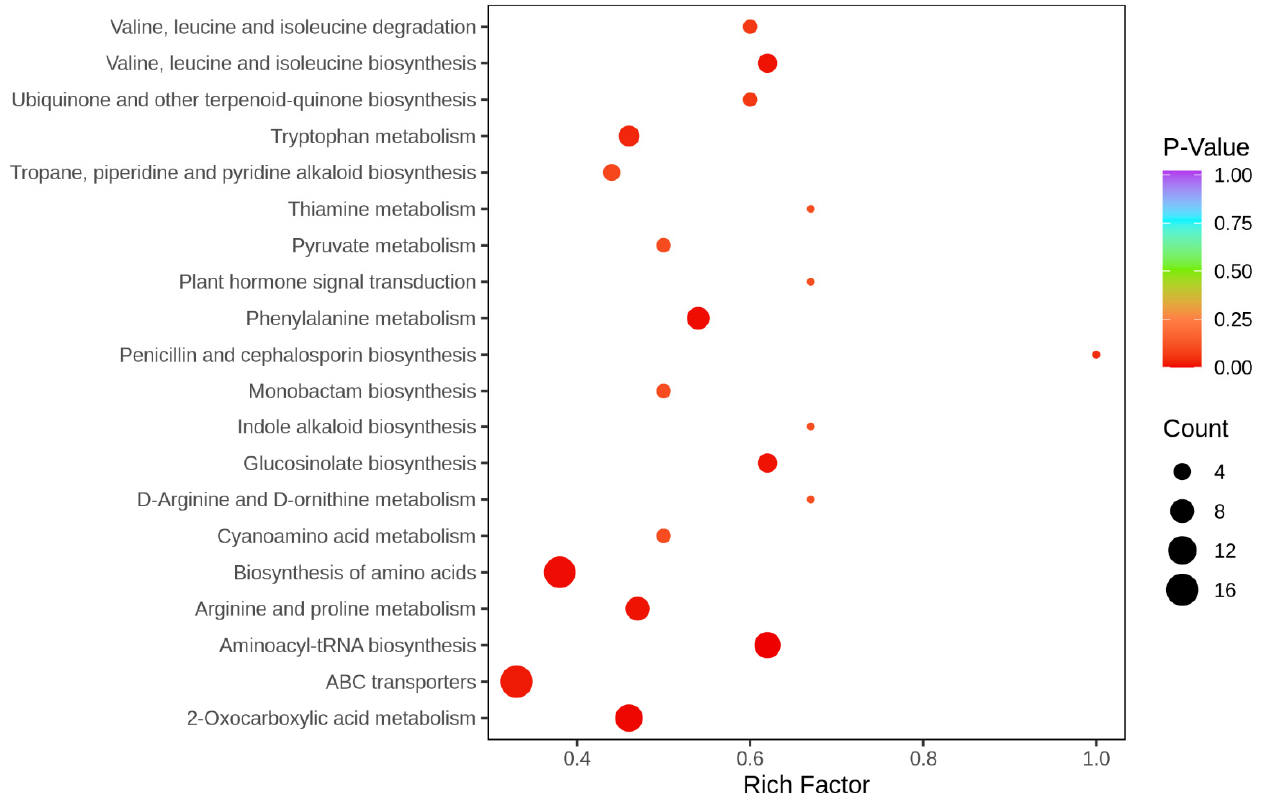
Figure 7. Top 20 enriched KEGG pathways in a comparison of CG and DS metabolomes.